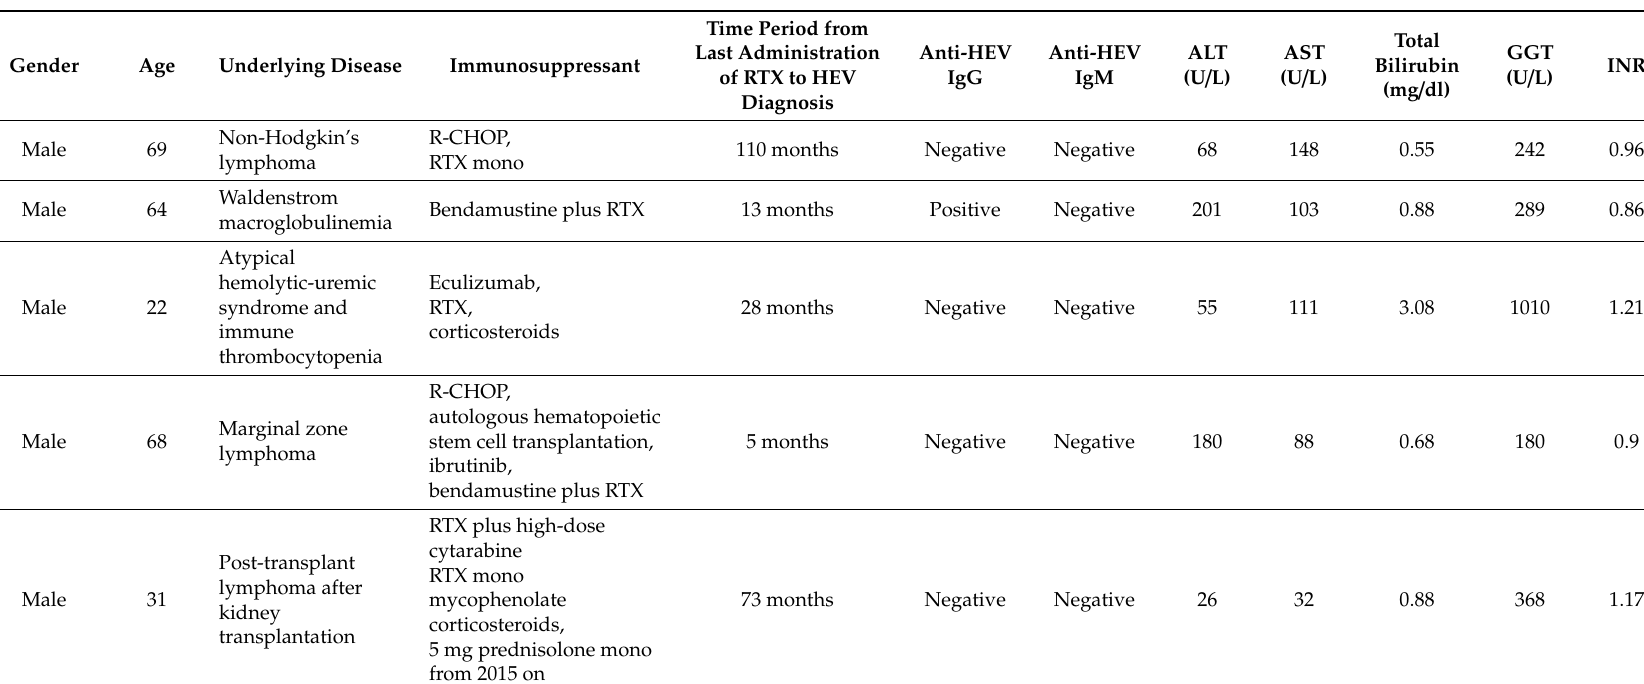
Table 2. Underlying disease, immunosuppressive medication, time from last administration of rituximab (RTX) to HEV diagnosis, laboratory results, and HEV serology at the time of HEV